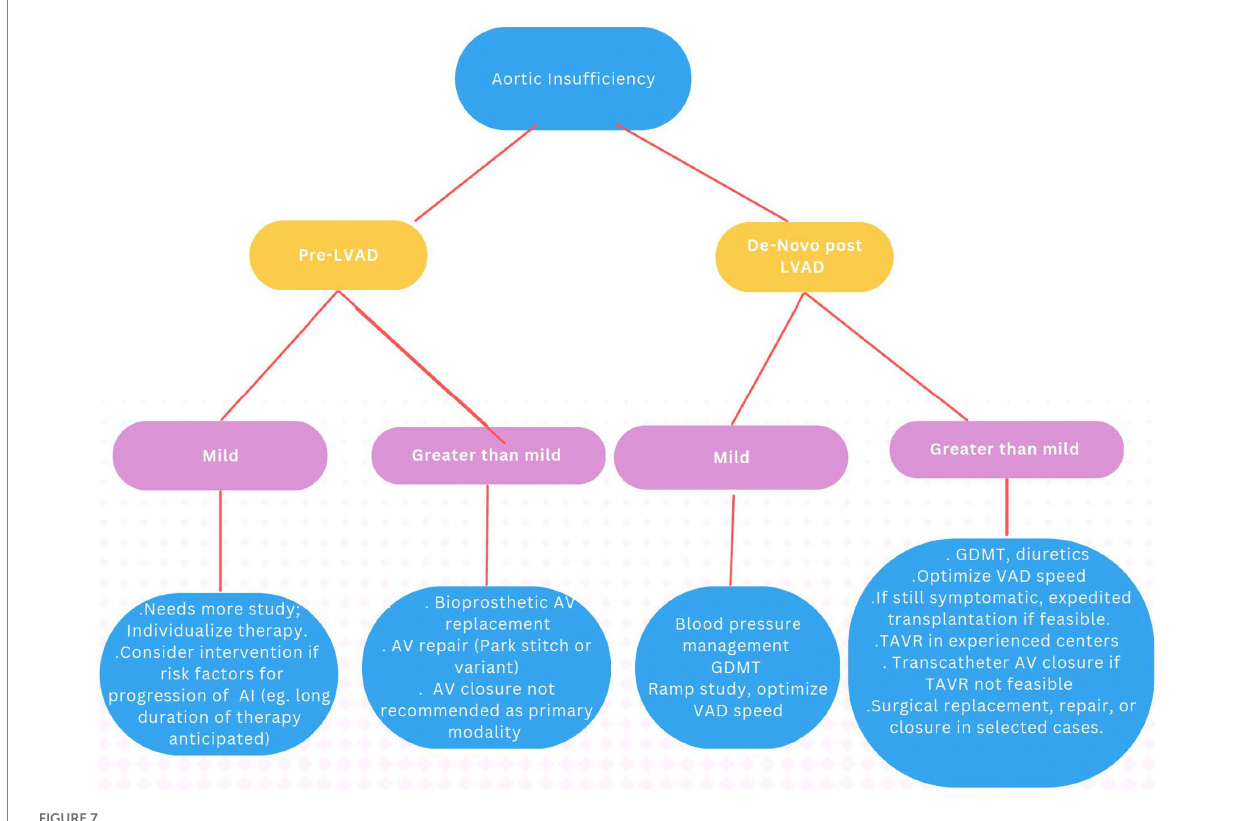
FIGURE 7 Recommendations for management of aortic